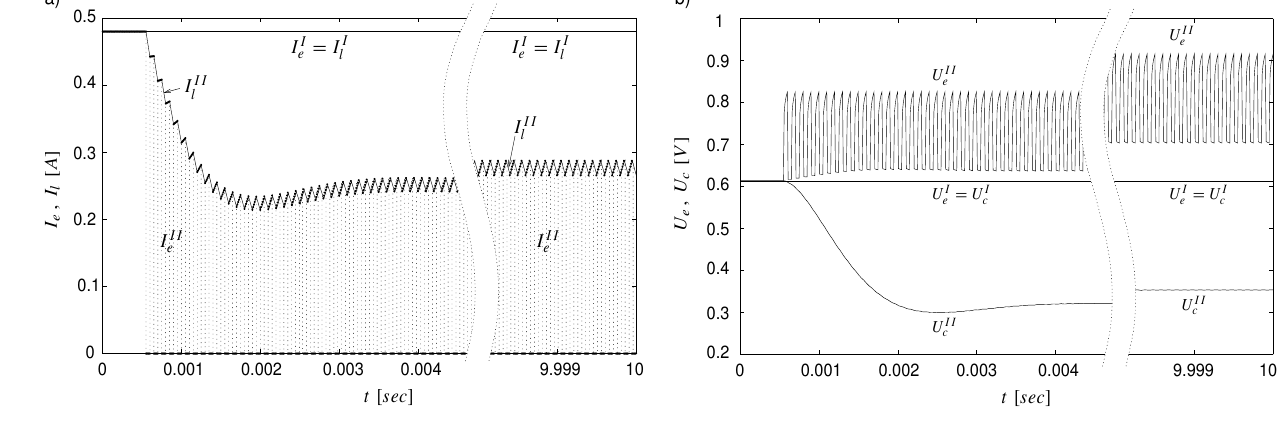
and cell (=converter input) current I l and capacitor (=converter output) e